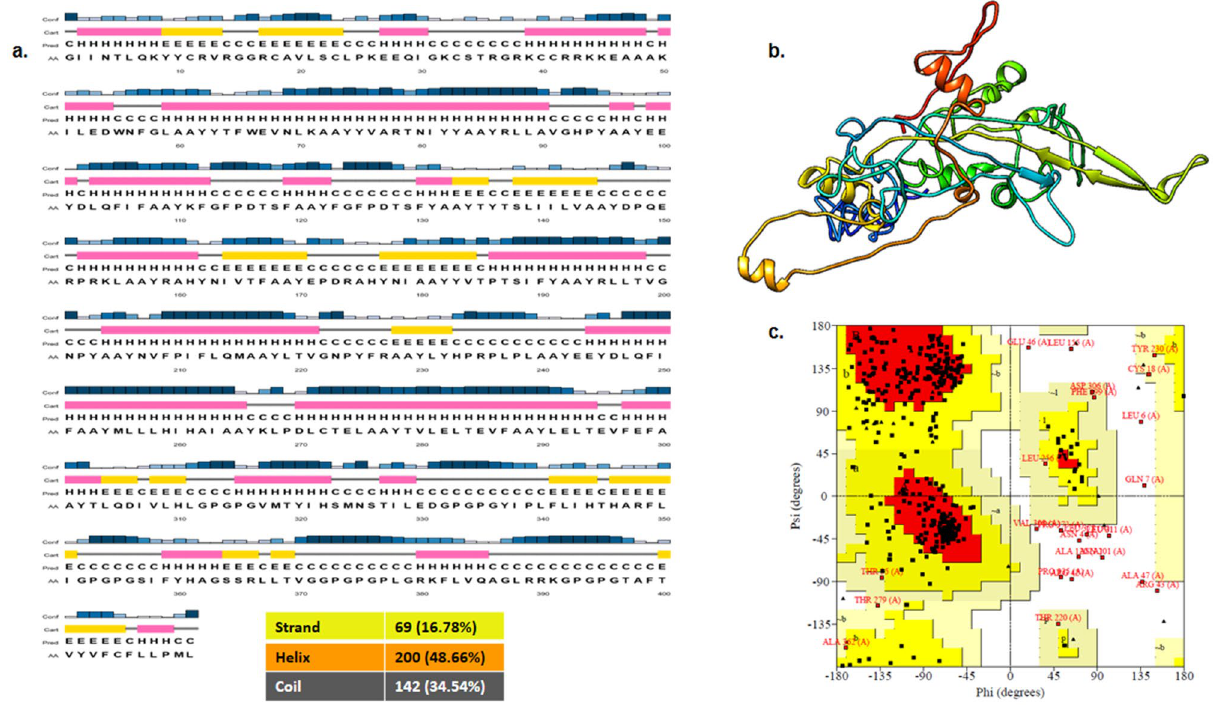
Figure 3. Predicted 2D and 3D structure of the construct, ( a ). Predicted 2D structure of the multi-epitope chimeric vaccine construct, ( b ). Predicted 3D structure of the multi-epitope chimeric vaccine construct by the online I-TASSER server (https:// zhang lab. ccmb. med. umich. edu/I- TASSER). The 3D structure of the protein was visualized in UCSF Chimera version1.13rc https:// www. rbvi. ucsf. edu/ chime ra. ( c ). Ramachandran Plot analysis of the multi-epitope chimeric vaccine